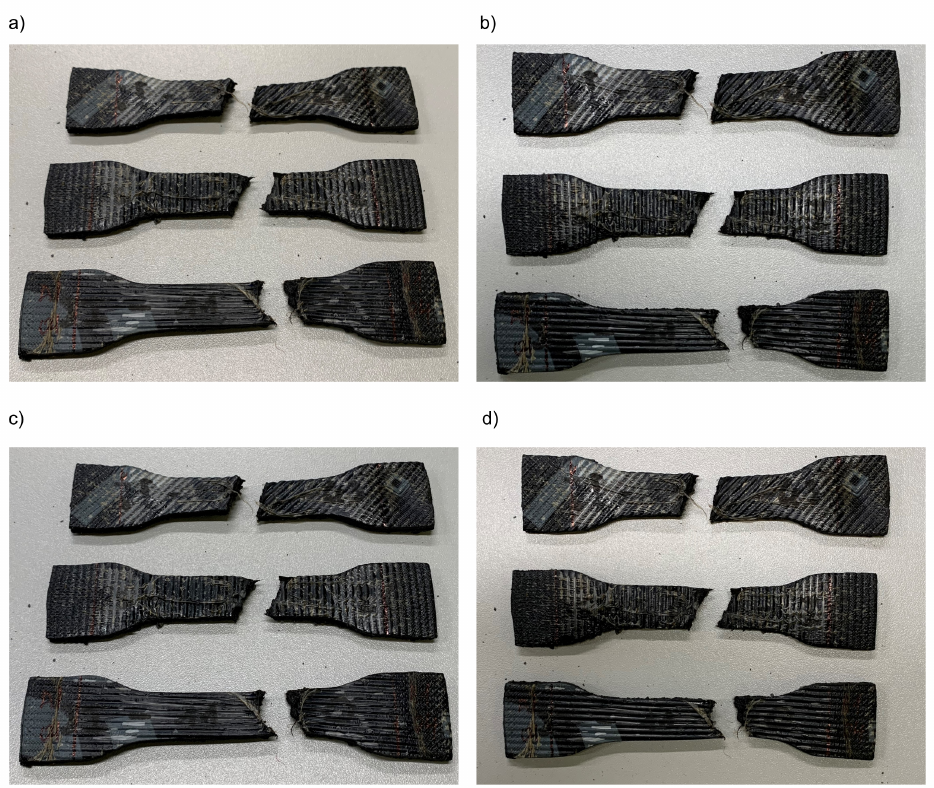
Figure 2. M1 material samples ( a – d ) prepared according to [62] with 0°, 45°, 90° angle of reinforce- ment relative to the sample’s longitudinal axis. Samples after the tensile